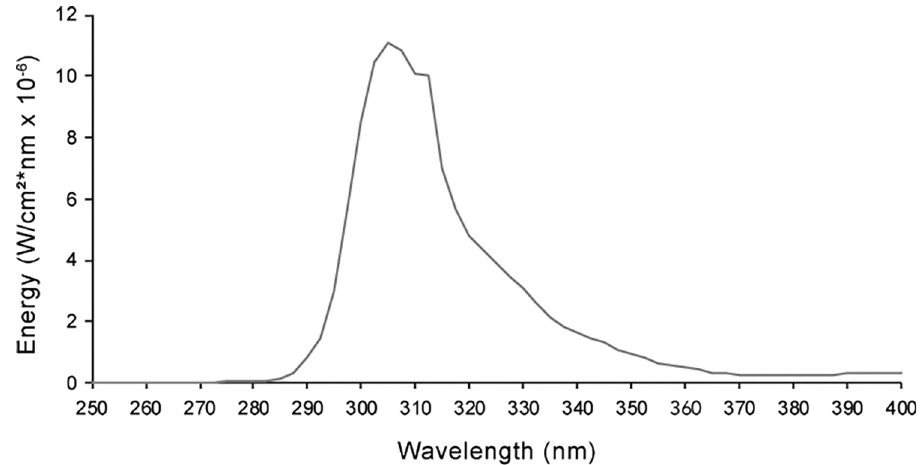
Fig 1. Emission spectrum of the UVR lamp (RPR-3000) after filtering through a Kodacel TA-407 clear 0.015” filter. The spectrum was derived from manufacturer’s specifications and was confirmed by our measurement using